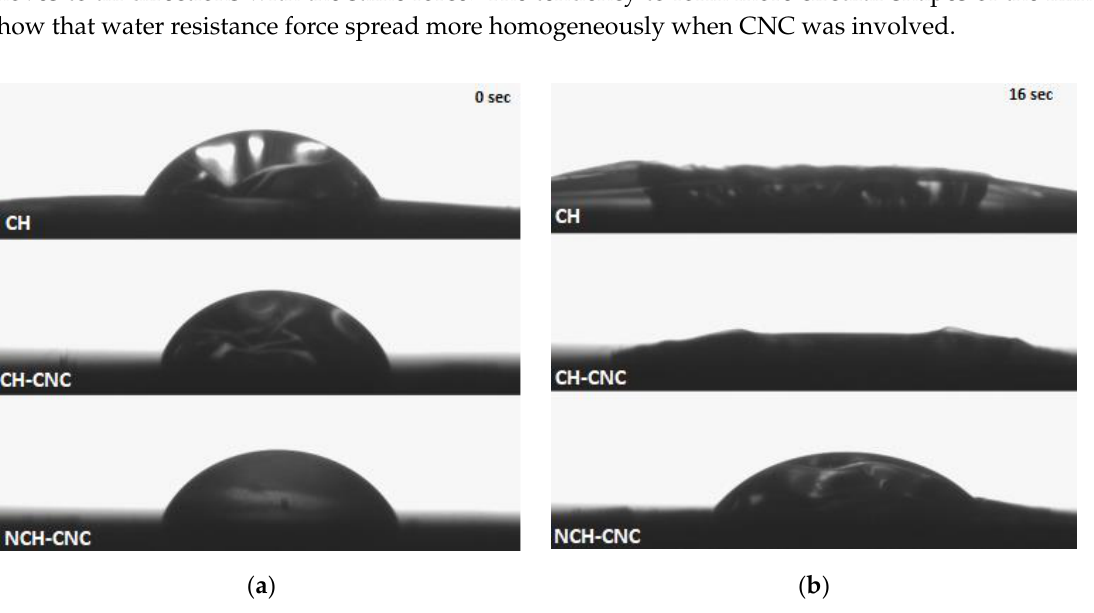
Figure 9. Record of water droplet penetration on film composites: ( a ) initial condition at 0 s, ( b ) after film absorb water liquid at 16 s.